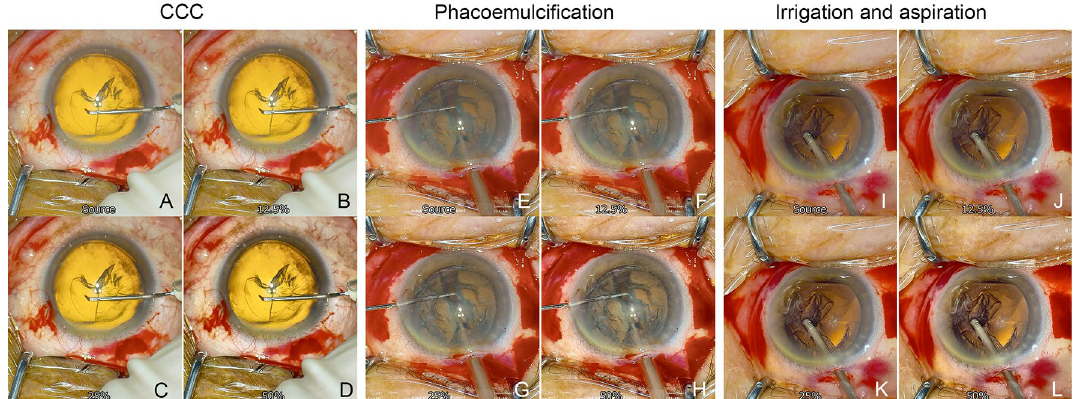
Figure 3. Surgical images during cataract surgery. Surgical image during anterior capsulotomy by continuous curvilinear capsulorhexis (CCC) with the original image ( A ), 12.5% ( B ), 25% ( C ), and 50% ( D ) intensity of image-sharpening algorithms. The images show that the edge of the anterior capsulotomy is sharper with increasing intensity of the image-sharpening algorithms. In addition, the patterns of the conjunctival vessels are also enhanced with the increase of the intensity of the image-sharpening. Surgical images during phacoemulsification of the lens nucleus with the original image ( E ), 12.5% ( F ), 25% ( G ), and 50% ( H ) intensity of image-sharpening indicate that the edge of the lens nucleus appears to be sharper with increasing intensity of the image-sharpening algorithms. Surgical images during aspiration of the lens cortex with the original image ( I ), 12.5% ( J ), 25% ( K ), and 50% ( L ) intensity of image-sharpening show that the edge of the lens cortex appears to be sharper with increasing intensity of the